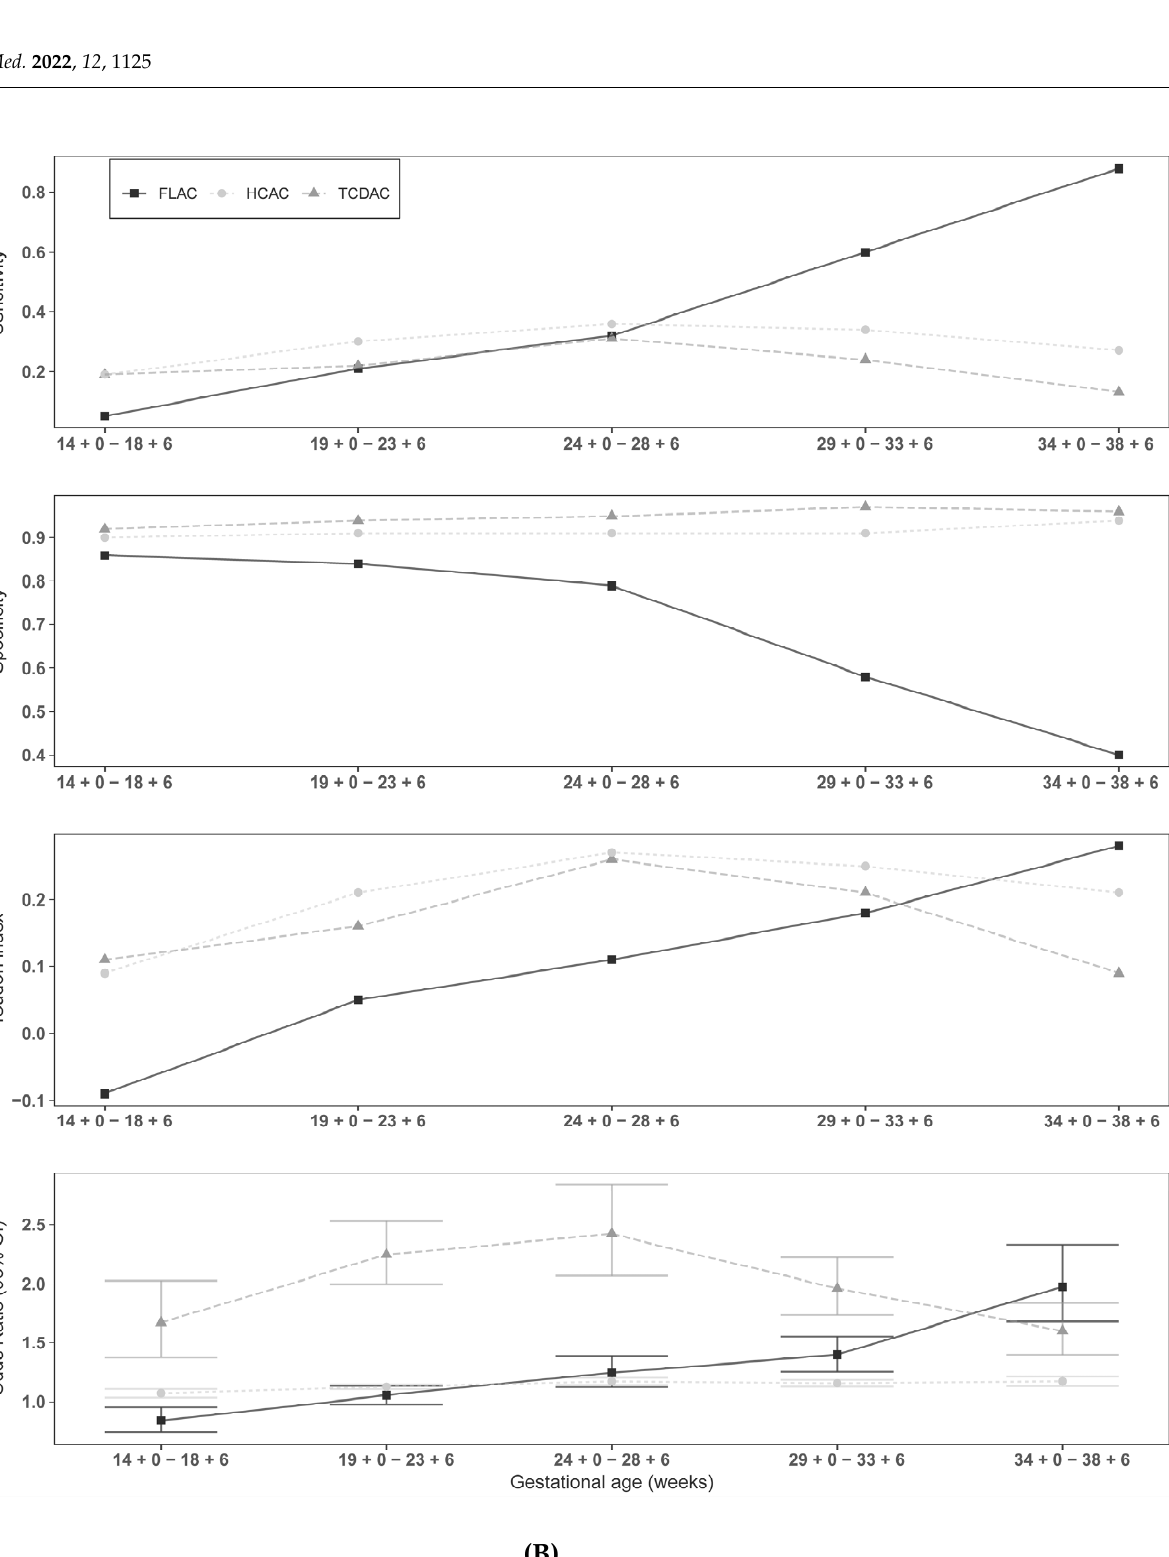
Figure 2. ( A ) Results of ultrasound variable cutoff values for detection of SGA. Results of gestational- age-dependent cutoff values are presented in Supplementary Table S5. AC = abdominal circumference, BPD = biparietal diameter, FL = femur length, HC = head circumference, TCD = transcerebellar diameter. ( B ) Results of the ultrasound ratio for SGA. Results of gestational-age-dependent cutoff values are presented in Supplementary Table S5. FL/AC = femur length/abdominal circumference, HC/AC = head circumfer- ence/abdominal circumference, TCD/AC = transcerebellar circumference/abdominal